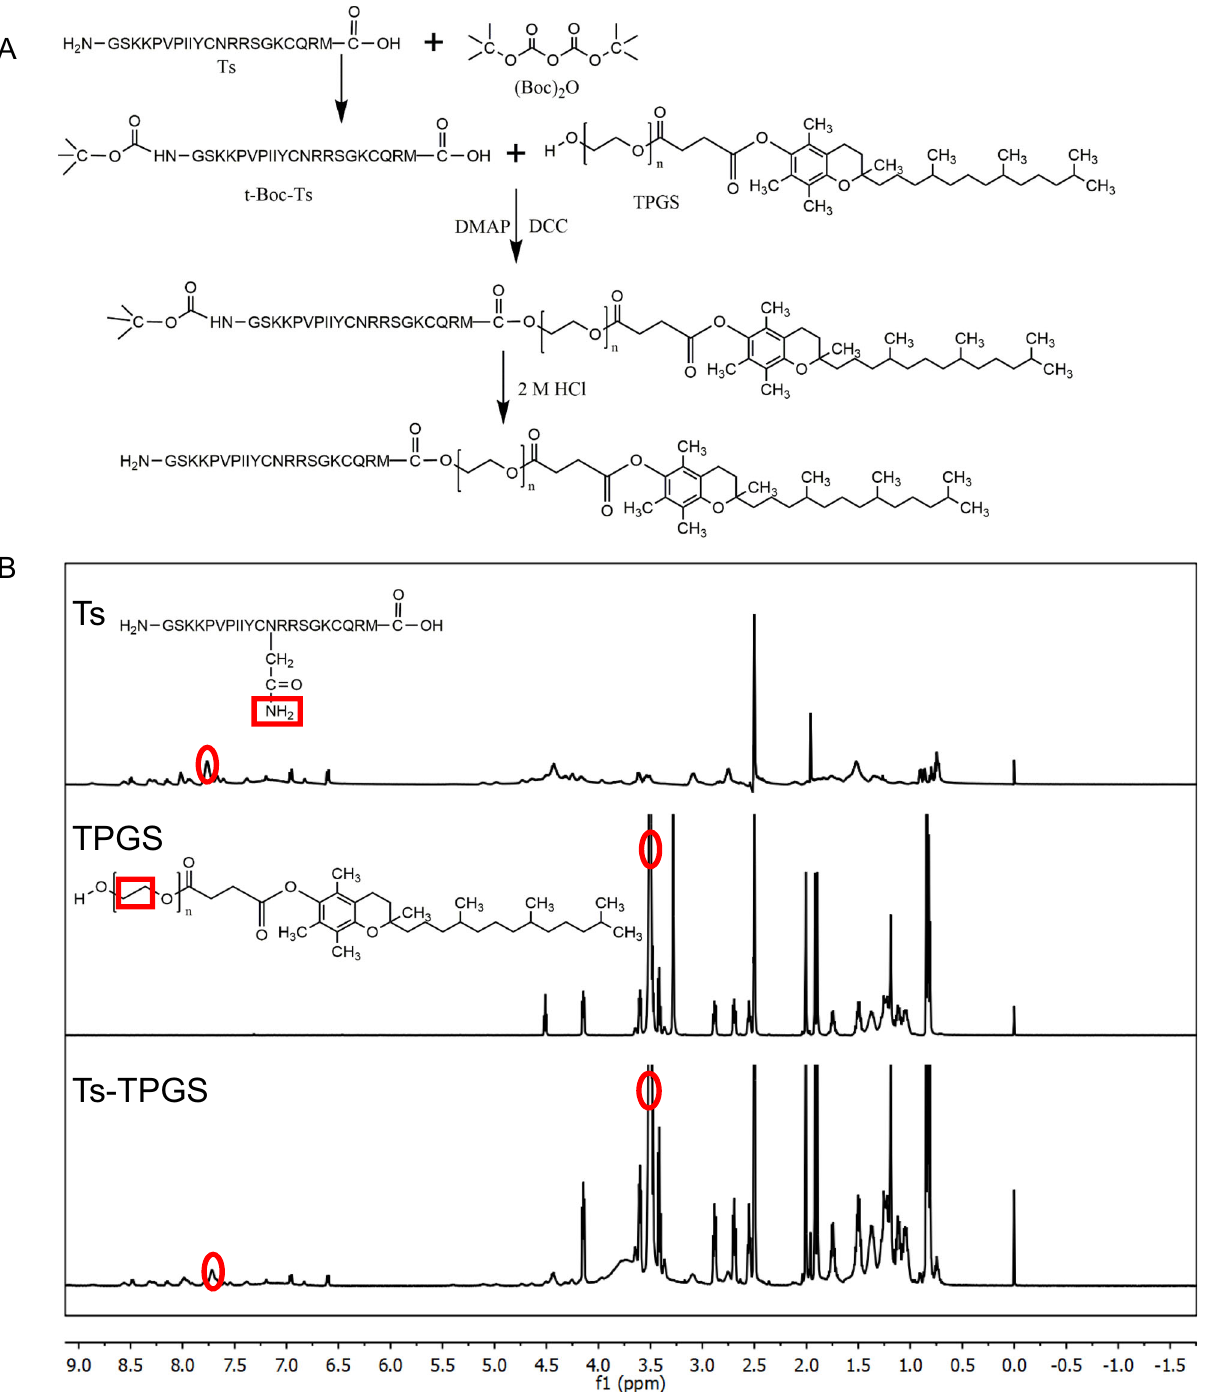
Fig. 2 Synthesis and characterization of Ts-TPGS (TT). A Synthetic scheme of the TT conjugate. B 1 H-NMR spectra of Ts peptide, TPGS, and TT from top to bottom. The red circles represented the characteristic peaks of the structure displayed in red squares, in which ~ 3.5 ppm represented the -O-CH2-CH2- of TPGS and ~ 7.7 ppm indicated the -CONH2 of Ts peptide. Ts S-thanatin peptide, TPGS tocopheryl polyethylene glycol